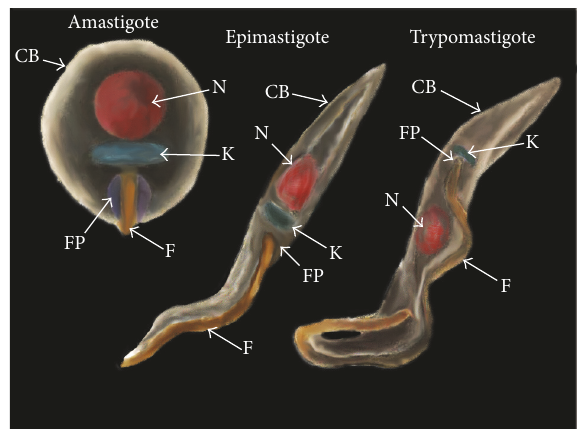
Figure 1: The different stages of Trypanosoma cruzi . The image depicted the amastigote, epimastigote, and trypomastigote stages from T. cruzi and their membrane domains: nucleus (N); kinetoplast (K); flagellum (F); flagellar pocket (FP); and cell body